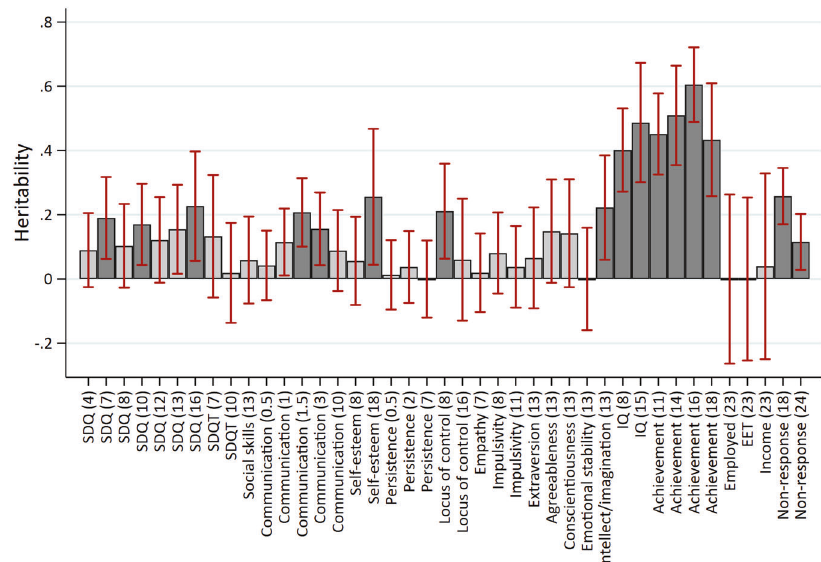
Fig. 5 Heritability of skills and outcomes. Age (years) in parentheses. Dark shaded bars represent estimates below FDR threshold. Heritability estimated using GCTA-GREML on the full sample available for each phenotype. SDQ: parent reported strengths and dif fi culties questionnaire; SDQT: teacher reported strengths and dif fi culties questionnaire. EET: in education, employed or training. See Supplementary Table 8 for full estimates.